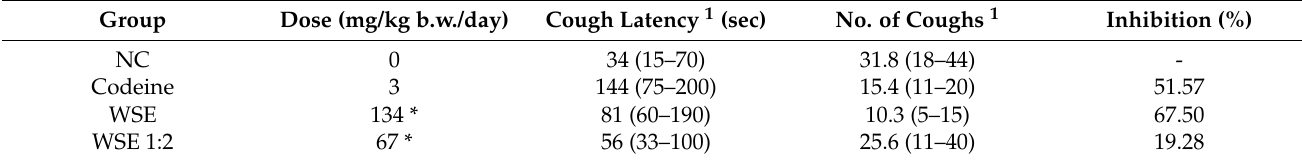
Table 1. Effects of different treatments on the citric acid-induced cough in rats. Group